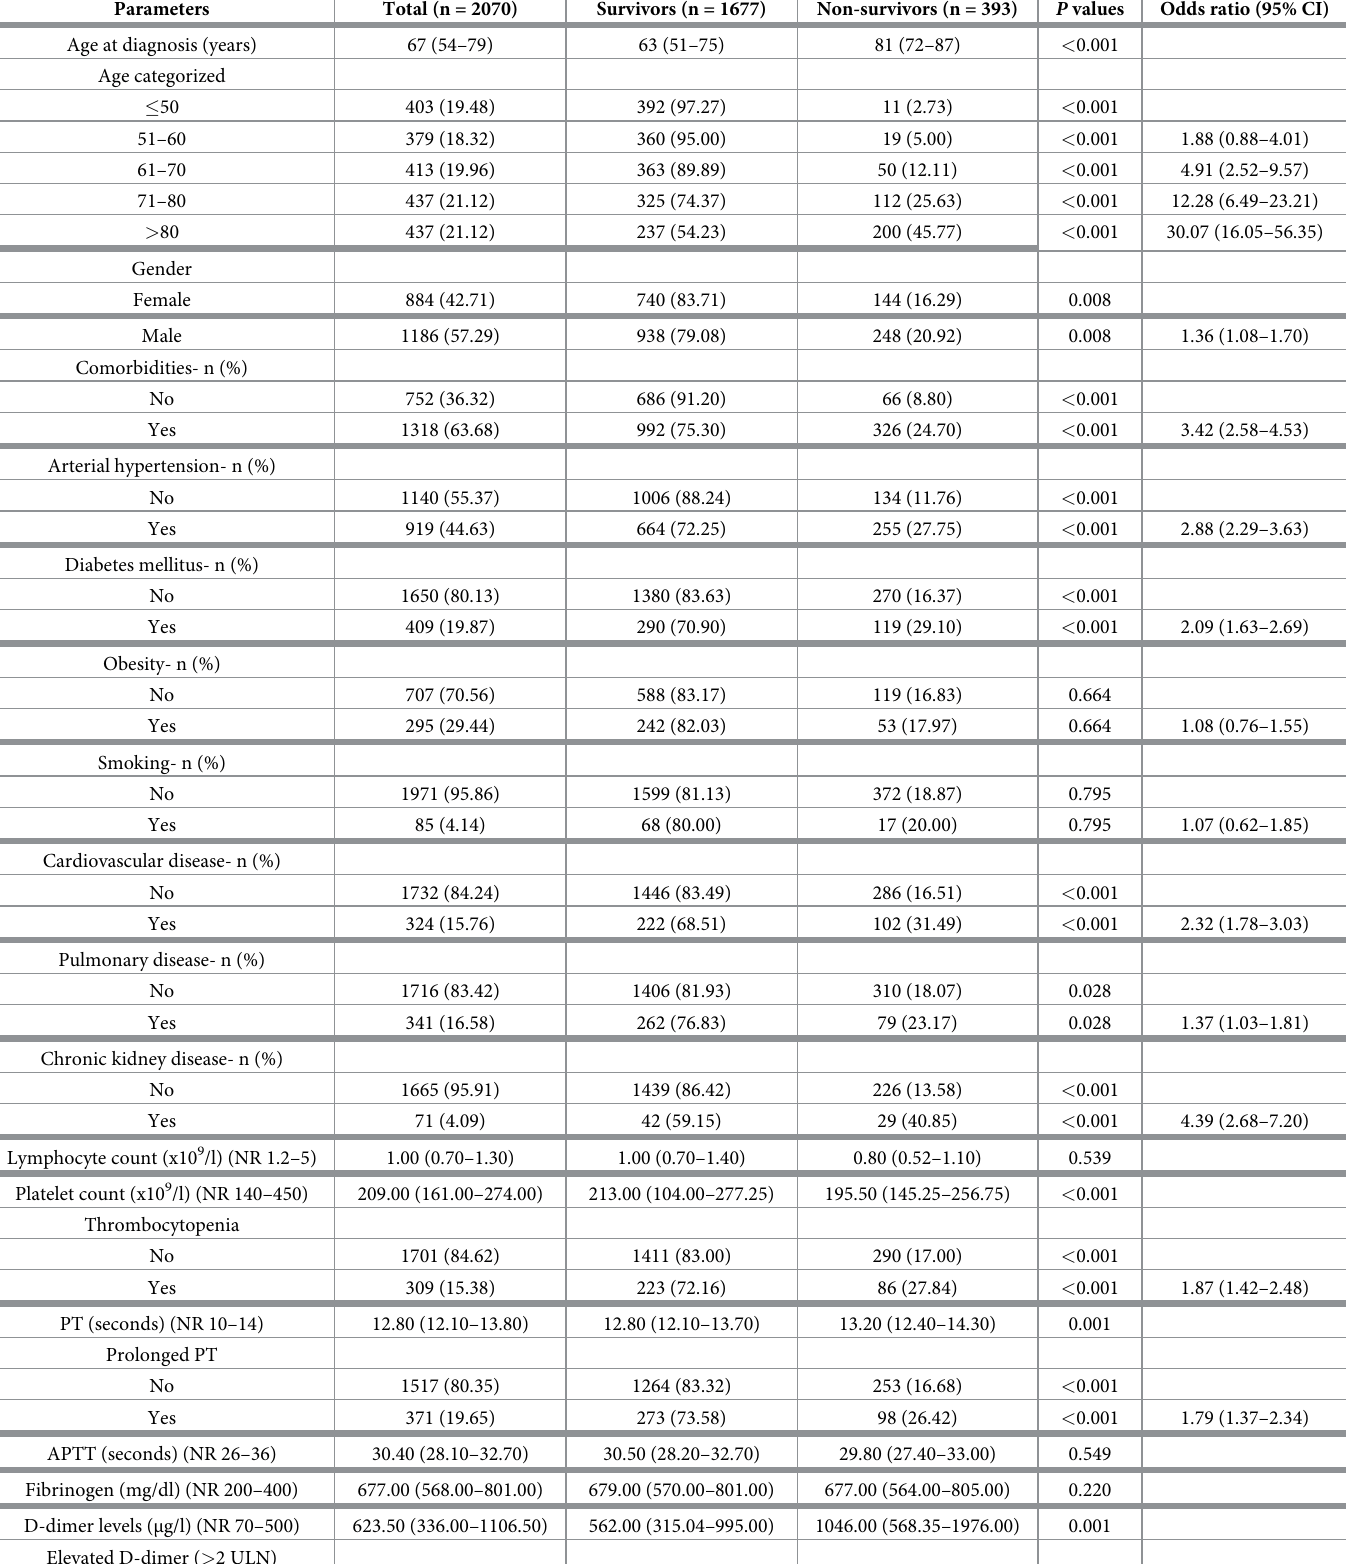
Table 1. Baseline characteristics of survivors and non-survivors, and univariate